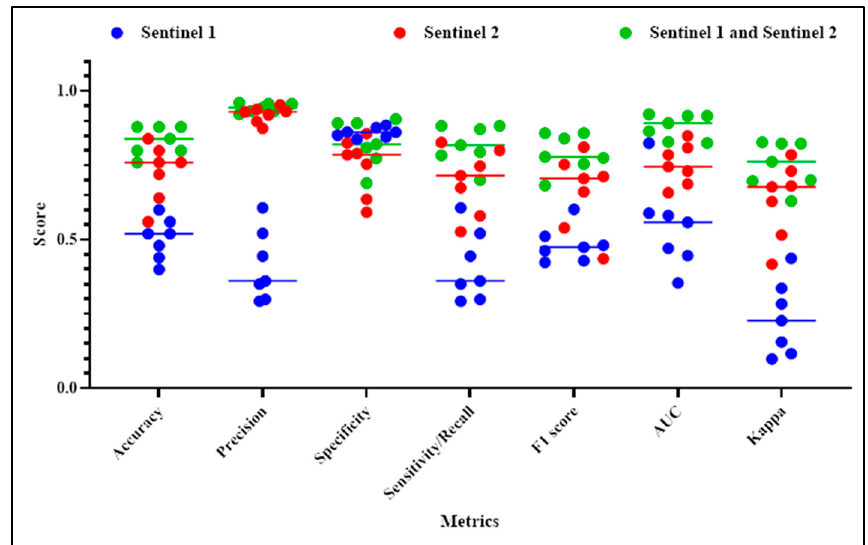
Figure 8. Data driven comparison of all metrics.